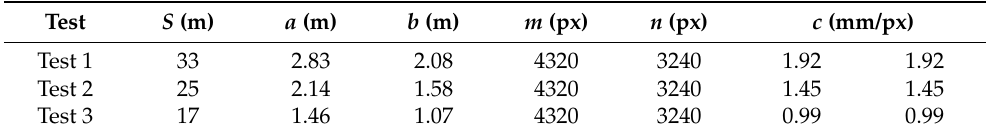
Table 2. Resolution values for different